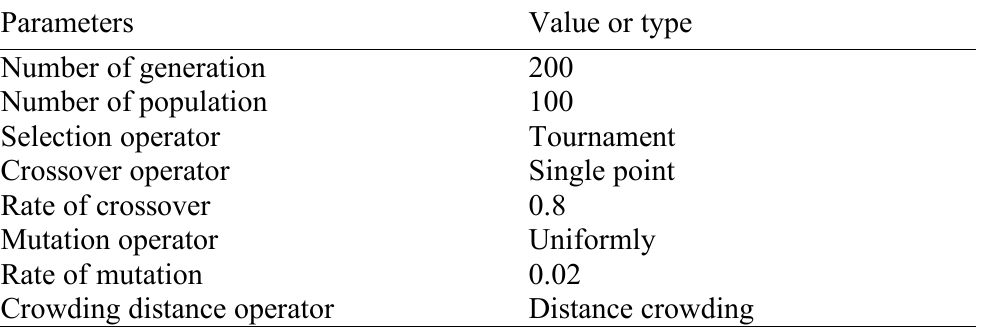
Table 1 . Input parameters of the NSGAII model